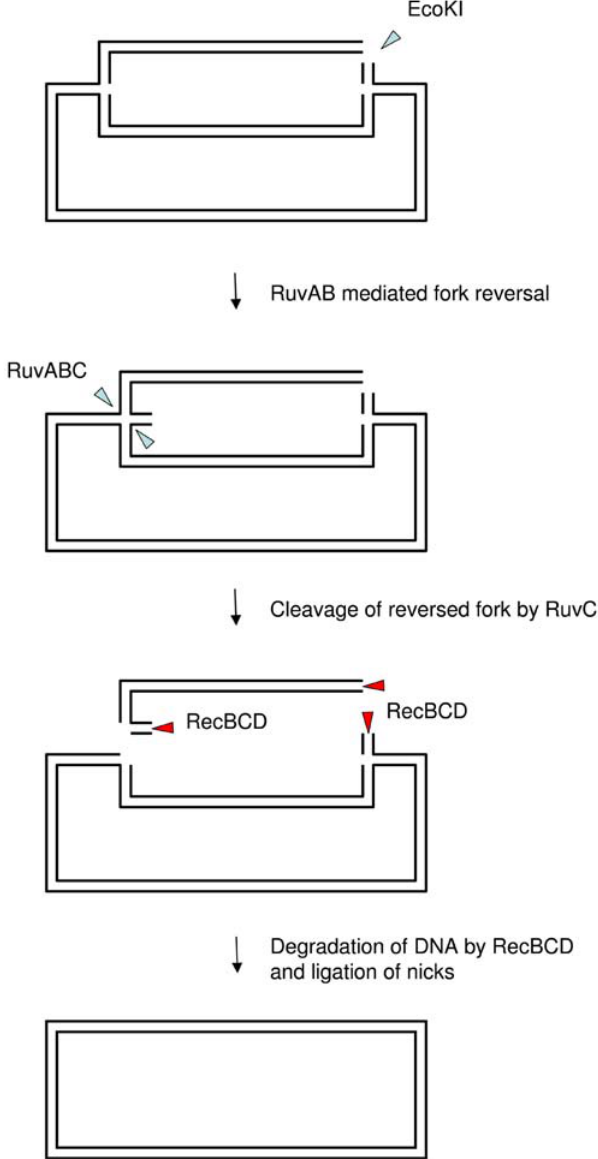
Figure 5. Illustration of how an intact monomeric circular chromosome might be generated without recombination following DNA double-strand breakage. In the absence of RecA, DSB repair would be prevented. Instead, a combination of replication fork reversal by RuvABC and DNA degradation by RecBCD could regenerate an intact circular chromosome and promote survival.